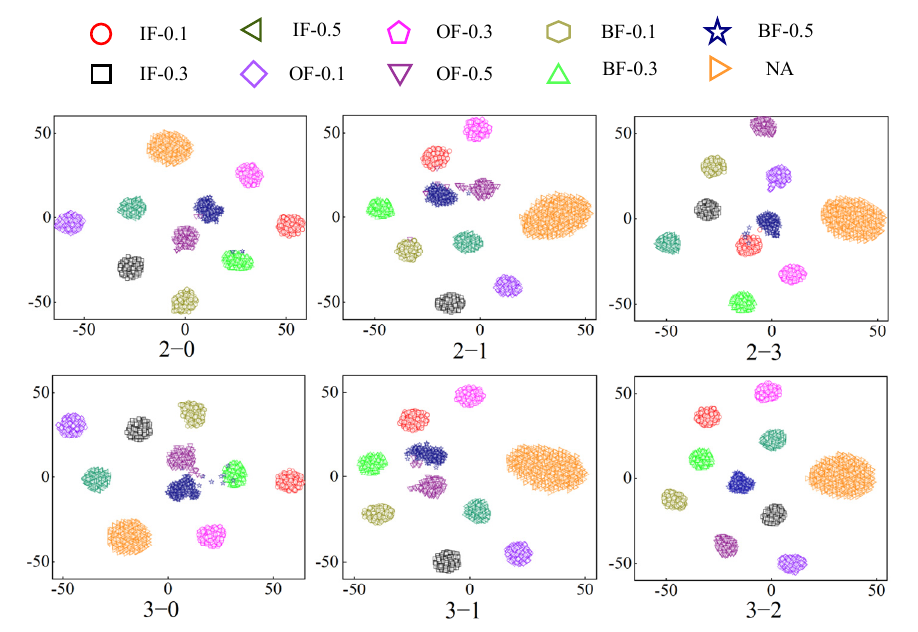
Figure 9. Feature visualization 2.